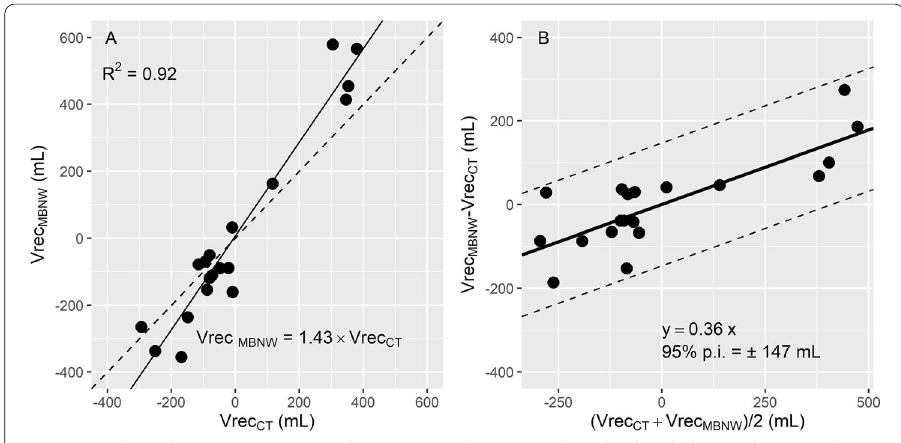
Fig. 5 Correlation between Vrec MBNW and Vrec CT ( A ) and corresponding Bland and Altman plot ( B ). Each symbol represents a concomitant measurement of alveolar recruitment assessed with the multi‑breath nitrogen washin–washout technique (Vrec MBNW ) and computed tomography (Vrec CT ). Negative recruited volumes denote alveolar derecruitment. A : Solid line is regression line. Dashed line is line of identity. B : continuous line and the 2 broken lines are the mean bias and 95% prediction interval limits of the bias between methods , respectively. 95% p.i. 95% prediction interval of the bias between =